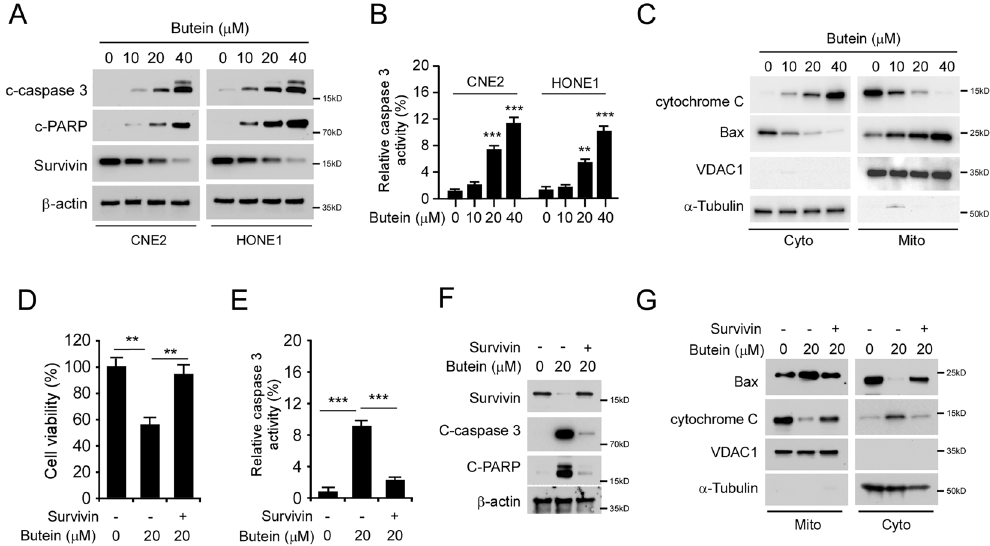
Figure 5. Butein promotes apoptosis. ( A and B ) CNE2 and HONE1 cells were treated with Butein for 24 h, the WCE was subjected to IB analysis ( A ), and caspase 3 activity was examined by Caspase 3 Assay Kit ( B ). ** p < 0.01, *** p < 0.001. ( C ) CNE2 cells were treated with Butein for 24 h, and subcellular fractions were isolated and subjected to IB analysis. ( D – G ) CNE2 cells were transfected with survivin construct for 24 h,